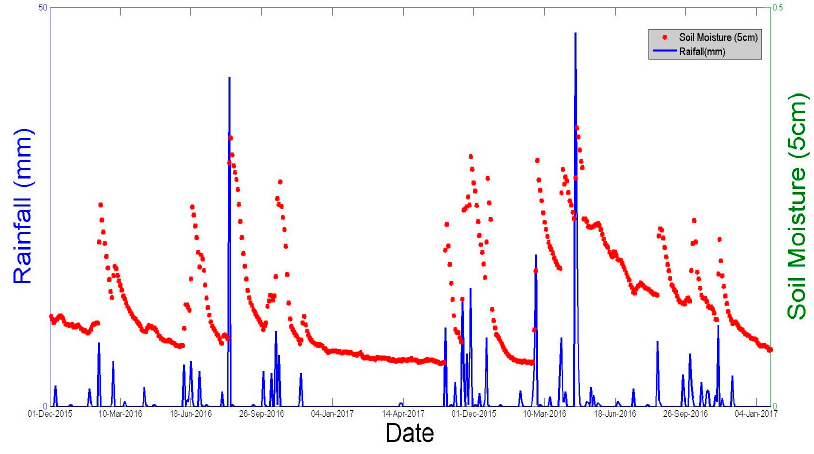
Figure 3. Daily precipitation and mean surface moisture over the studied site during the measurement campaigns.